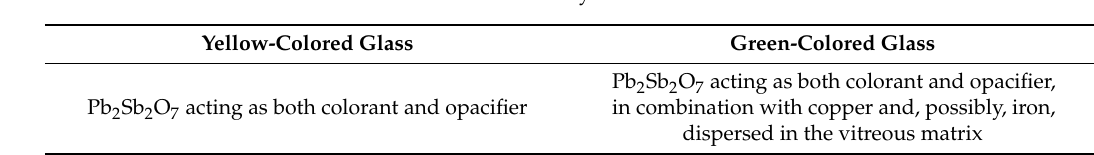
Table 2. Antimony-Based Phases.